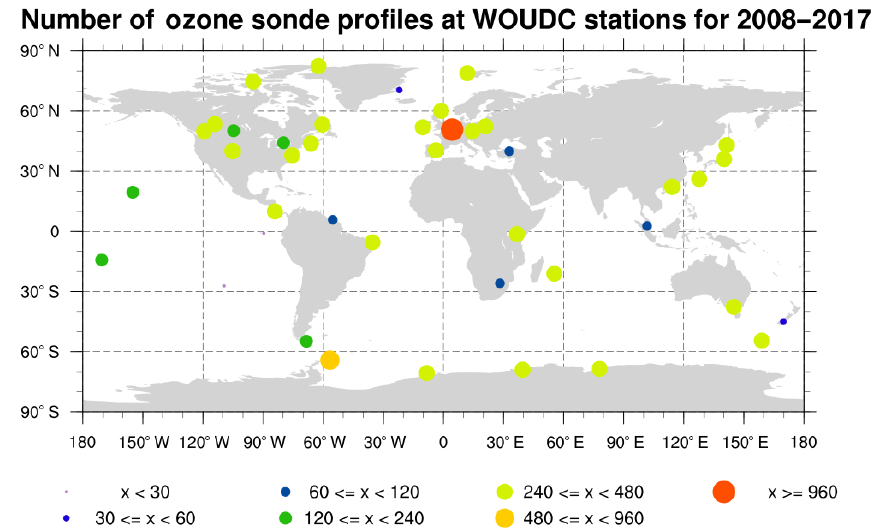
Figure 3. Maps of WOUDC stations with ECC O 3 sonde data during the 2008–2017 period. Colors and sizes of the markers indicate the number of valid sondes at each